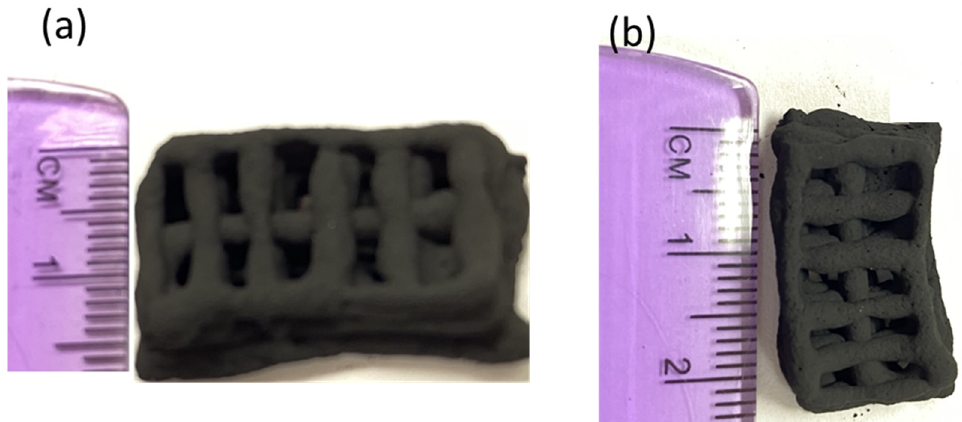
Figure 4. Optical image of 3D printed porous carbon monolith ( a , b ).